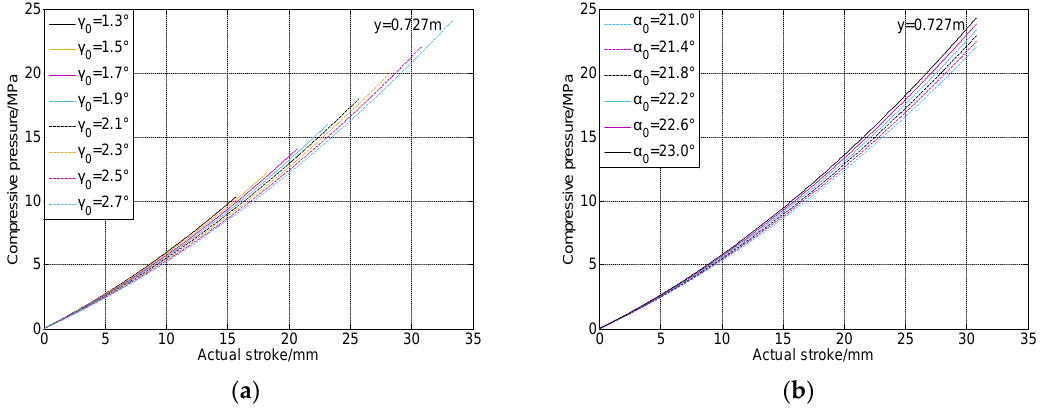
Figure 9. The influence of eccentric angle and nip angle on pressure: ( a ) relation of eccentric angle vs. pressure; ( b ) relation of nip angle and pressure.